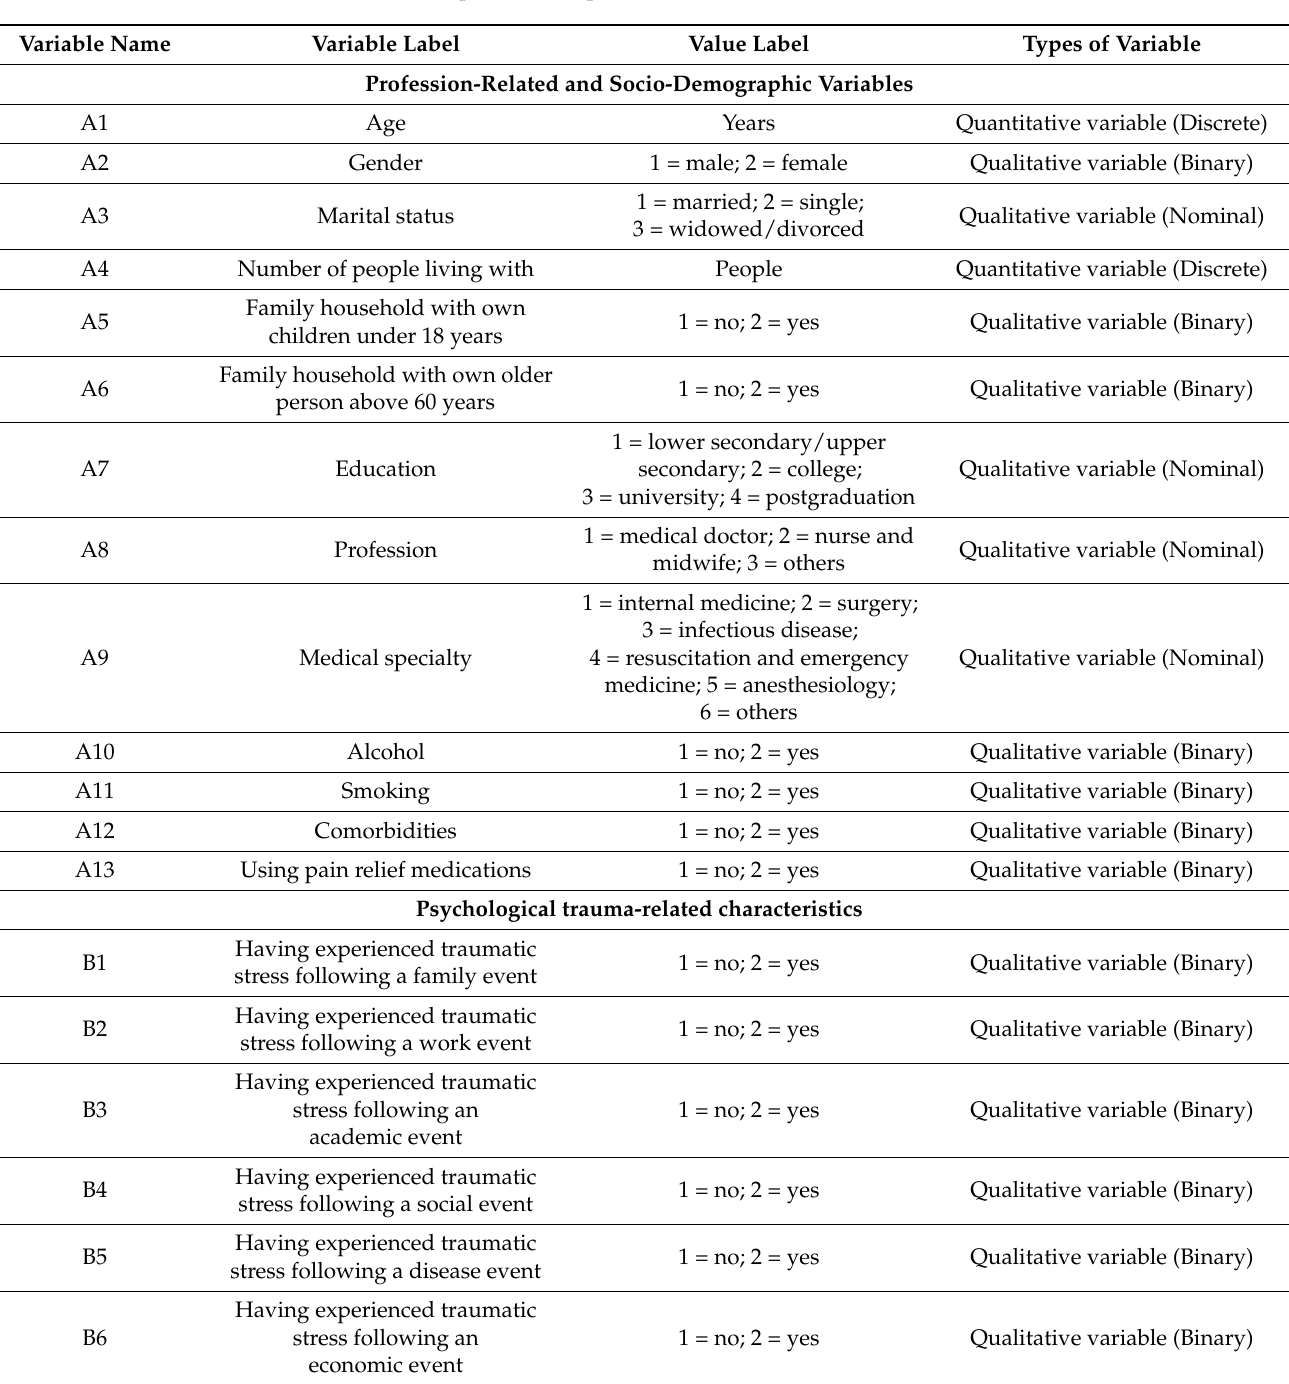
Table 1. Description of independent